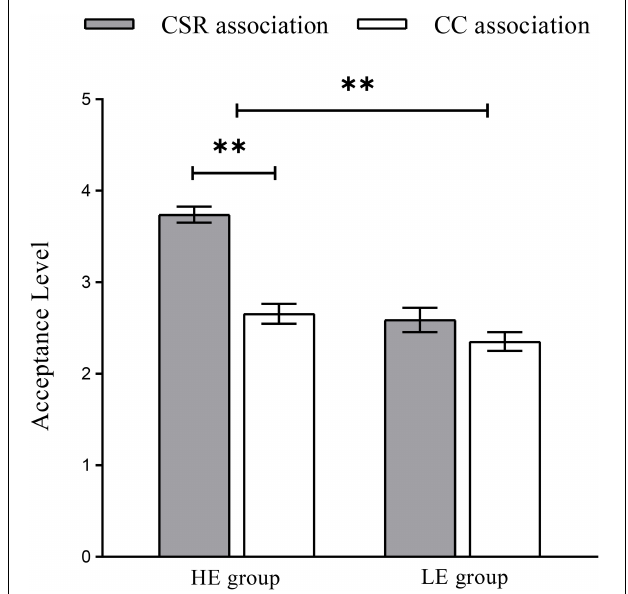
FIGURE 2 | The acceptance level of distant extension products under the corporate social responsibility (CSR) or corporate competence (CC) associations in HE and LE groups. ∗∗ p <